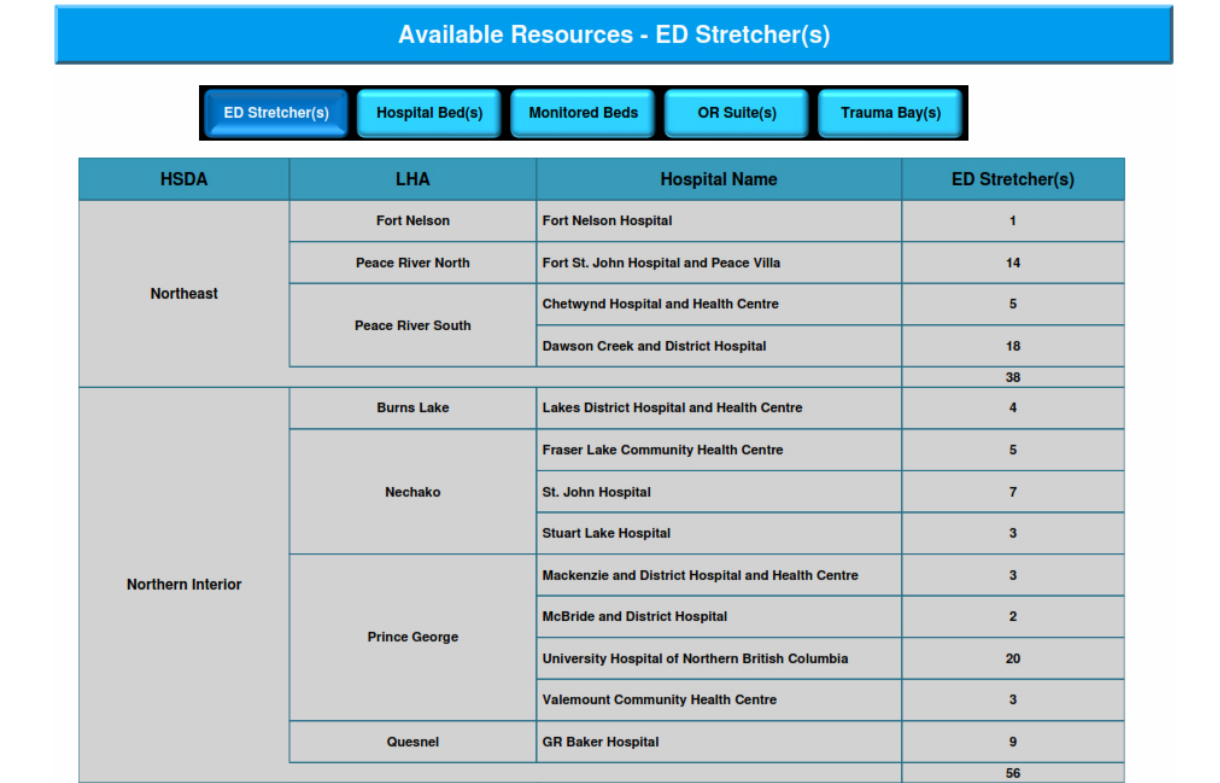
Figure 7. Available resources - drilldown report.